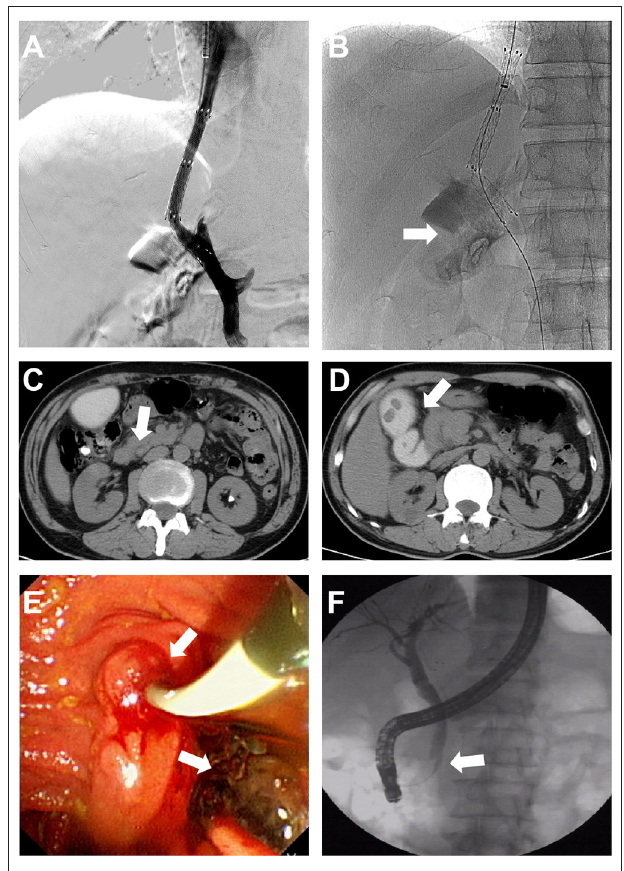
FIGURE 2 | Characteristics and management of hemobilia. (A,B) Bile duct was punctured during the procedure and contrast medium retention was found in the gallbladder. (C,D) Serum bilirubin elevated gradually after TIPS. CT showed bile duct dilatation, retention of contrast medium in the gallbladder, and high-density shadow of the common bile duct. (E,F) Endoscopic retrograde cholangiography (ERCP) showing a filling defect in the common bile duct, and the bleeding clot was cleared. The nasobiliary duct was retained for drainage.